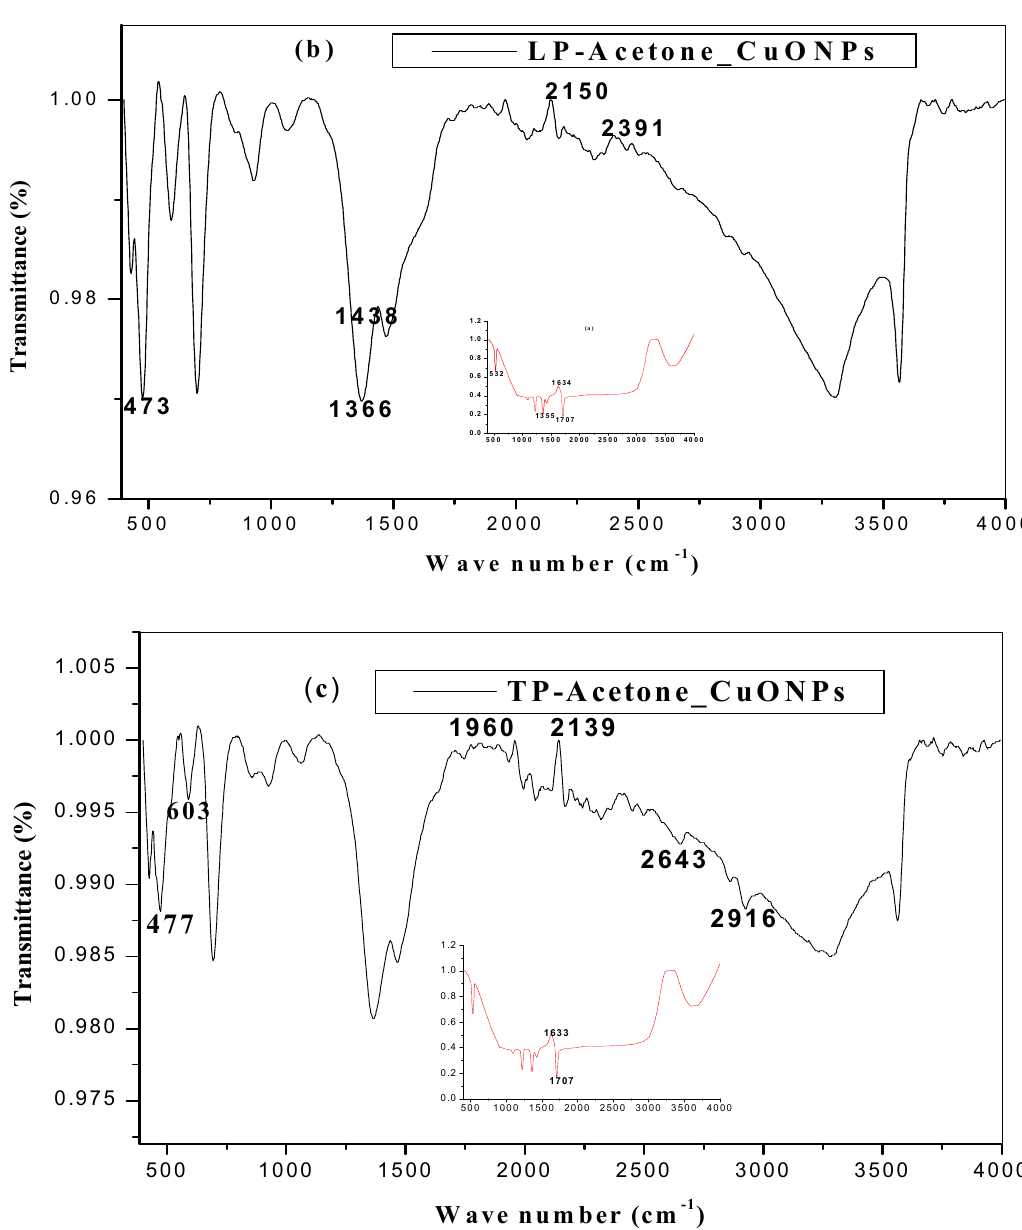
Figure 4. The FTIR spectra of CuONPs from ( a ) orange ( b ) lemon and ( c ) tangerine peel extracts in acetone; insert is the spectra for the respective citrus extracts.